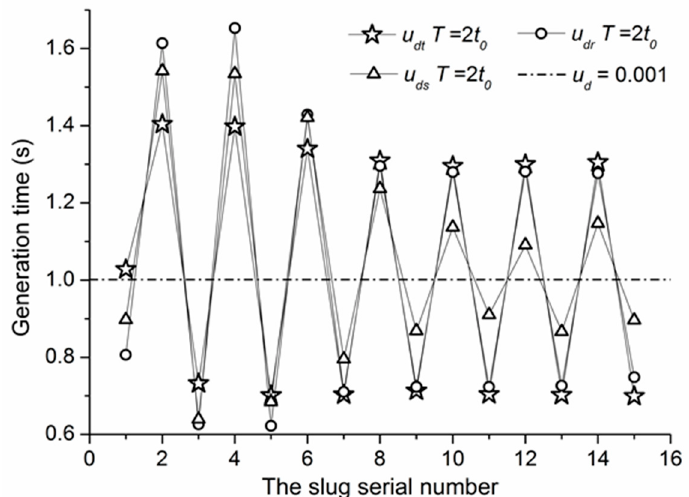
Figure 12. Slug generation time obtained from numerical simulations for dynamic dispersed ff erent injection flow rate of different types. flow rate of di